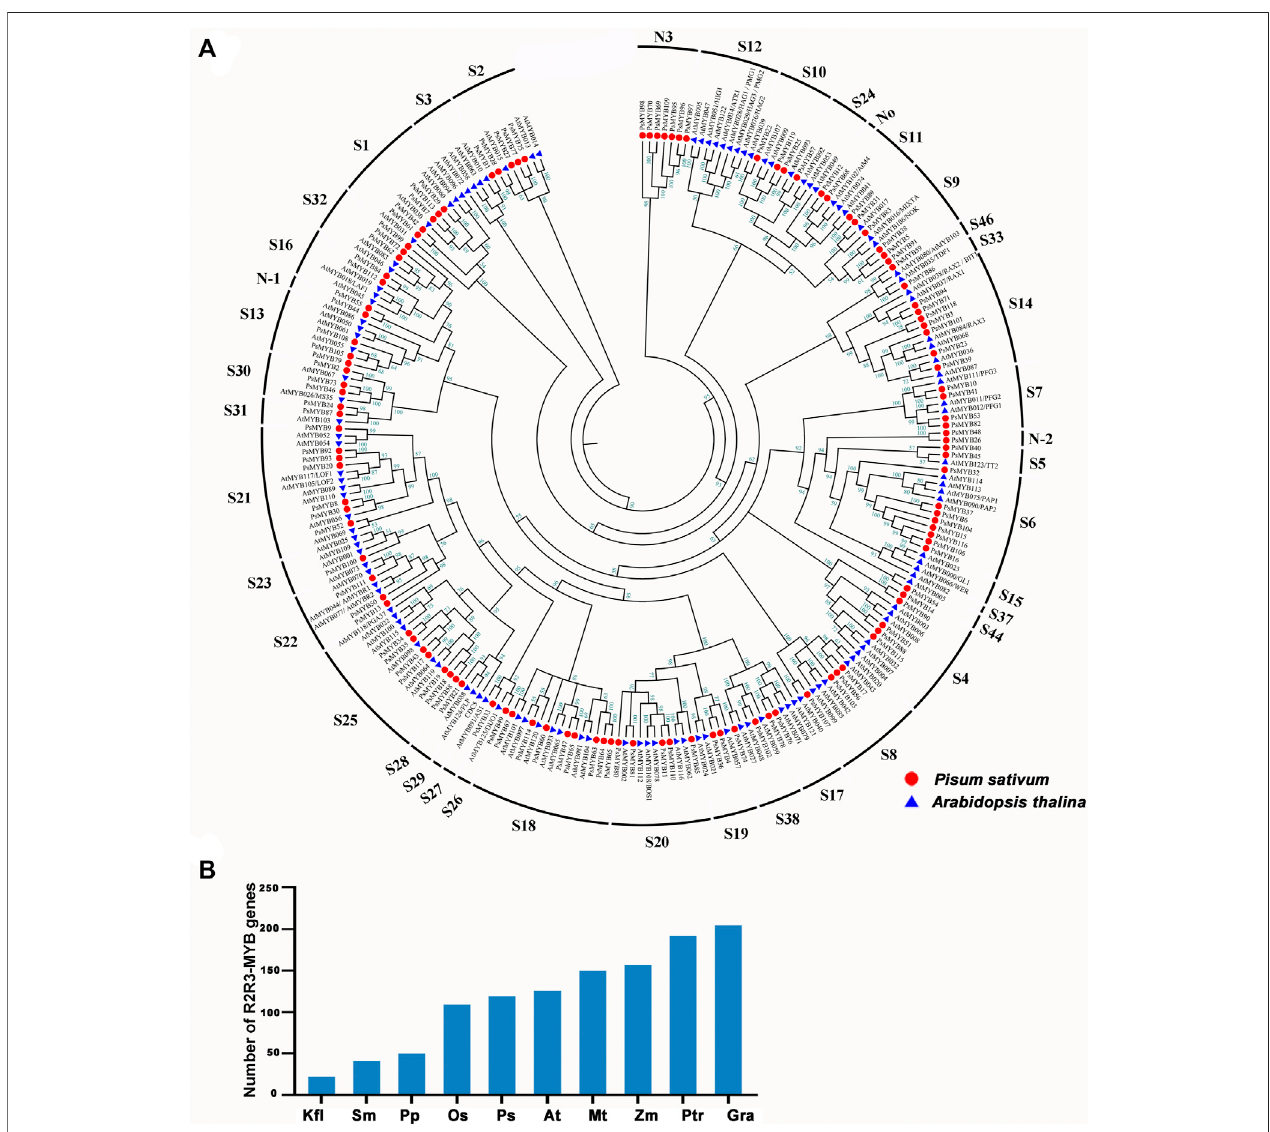
FIGURE 1 | Phylogenetic and evolutionary analysis of the R2R3-MYB gene family in different plant species. (A) The phylogenetic tree of R2R3-MYB genes in A . thaliana (At), P.sativum (Ps). Thirty-six subgroupswereobtained,namely,S1,S2, S3, S4,S5, S6,S7,S8, S9,S10, S11, S13,S14, S16, S17,S18, S19, S20,S21, S22, S23, S24, S25, S26, S27, S28, S30, S31, S32, S33, S38, S44, S46, N1, N2, N3. The genes that belonged to the same organism were marked in the same color. (B) Comparisons of R2R3-MYB genes number across a wide range of plant species. K fl , Klebsormidium nitens ; Sm, Selaginella moellemdorf fi i ; Pp, Physcomitrella patens ; Os, Oryza sativa ; Ps, Pisum sativum. L; At, Arabidopsis thaliana ; Mt, Medicago truncatula ; Zm, Zea mays; Ptr, Populus trichocarpa ; Gra, Gossypium raimondii